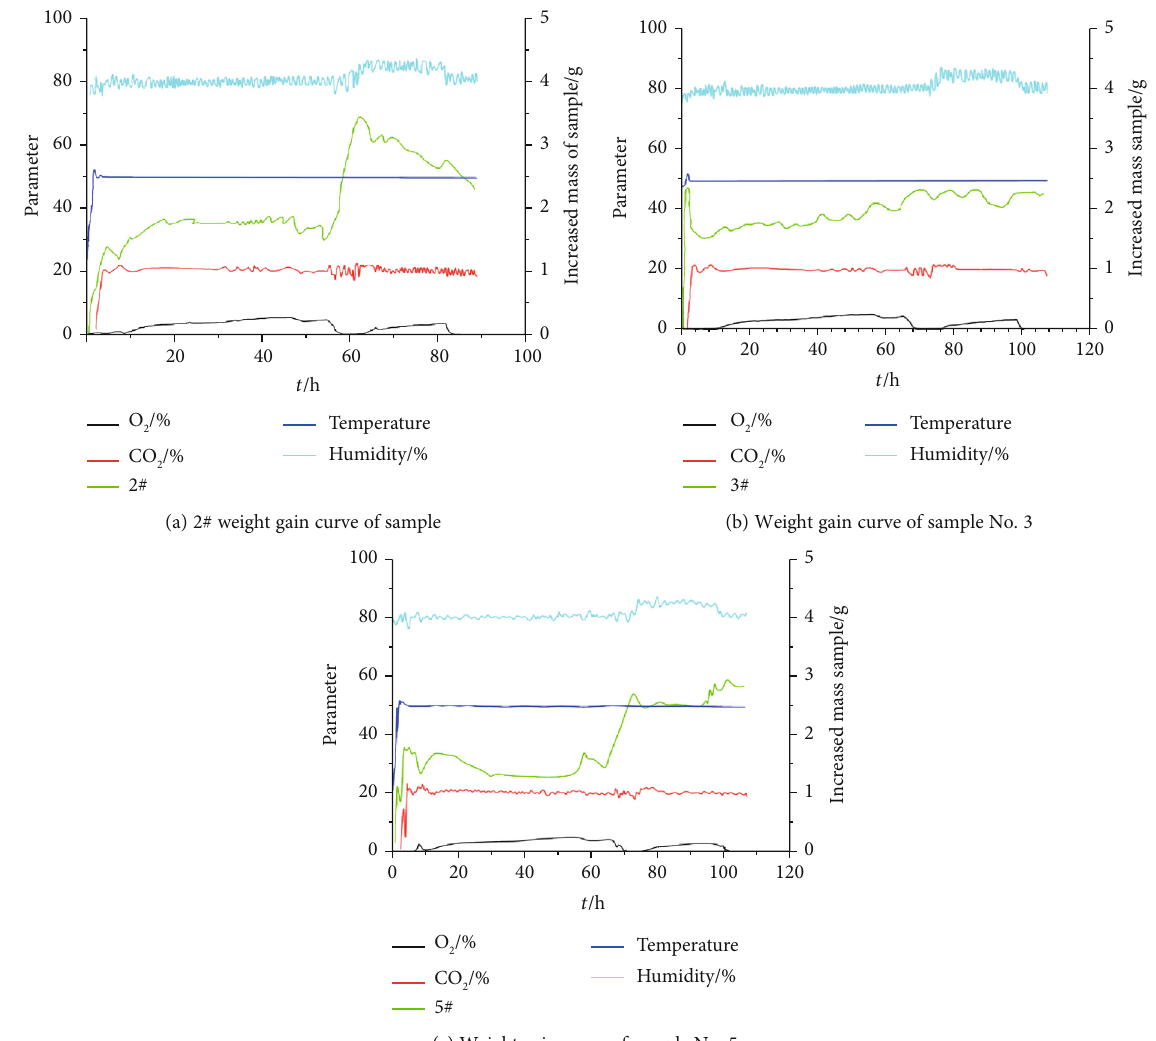
Figure 13: Experimental curve of the whole